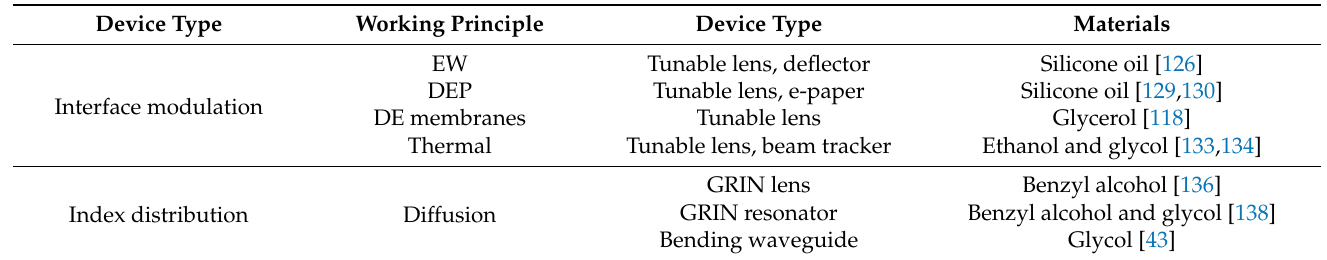
Table 2. A summarization of an isotropic liquid device with typical references